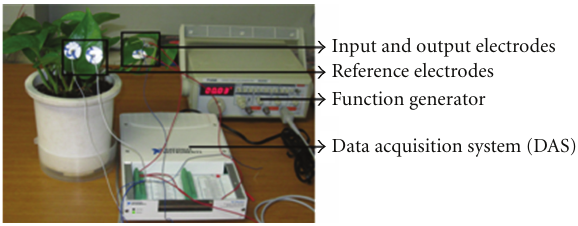
Figure 6: Apparatus for measuring the action potentials from the plant leaves.